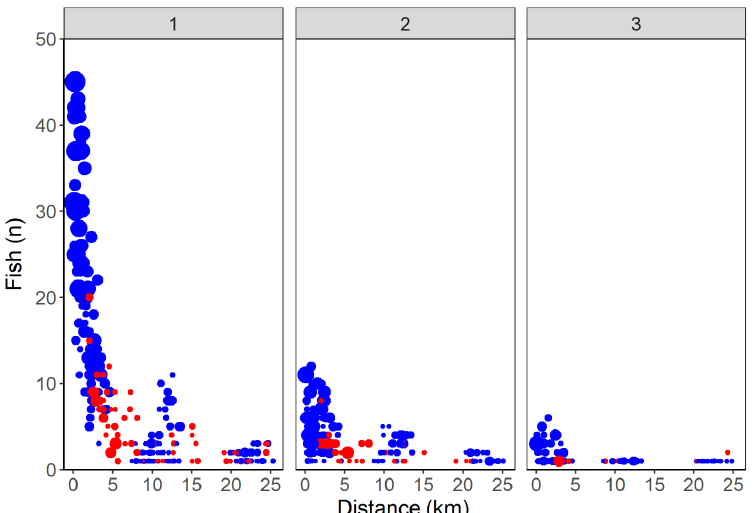
Fig. 2. Number of cod detected at a station versus the distance to station from release points across all stations. Left panel (1) represents number of fish on the year of release, middle panel (2) the year after release and right panel (3) the second year after release. Blue points: spawning ground stations; red points: farm stations. Size of points is scaled to the number of